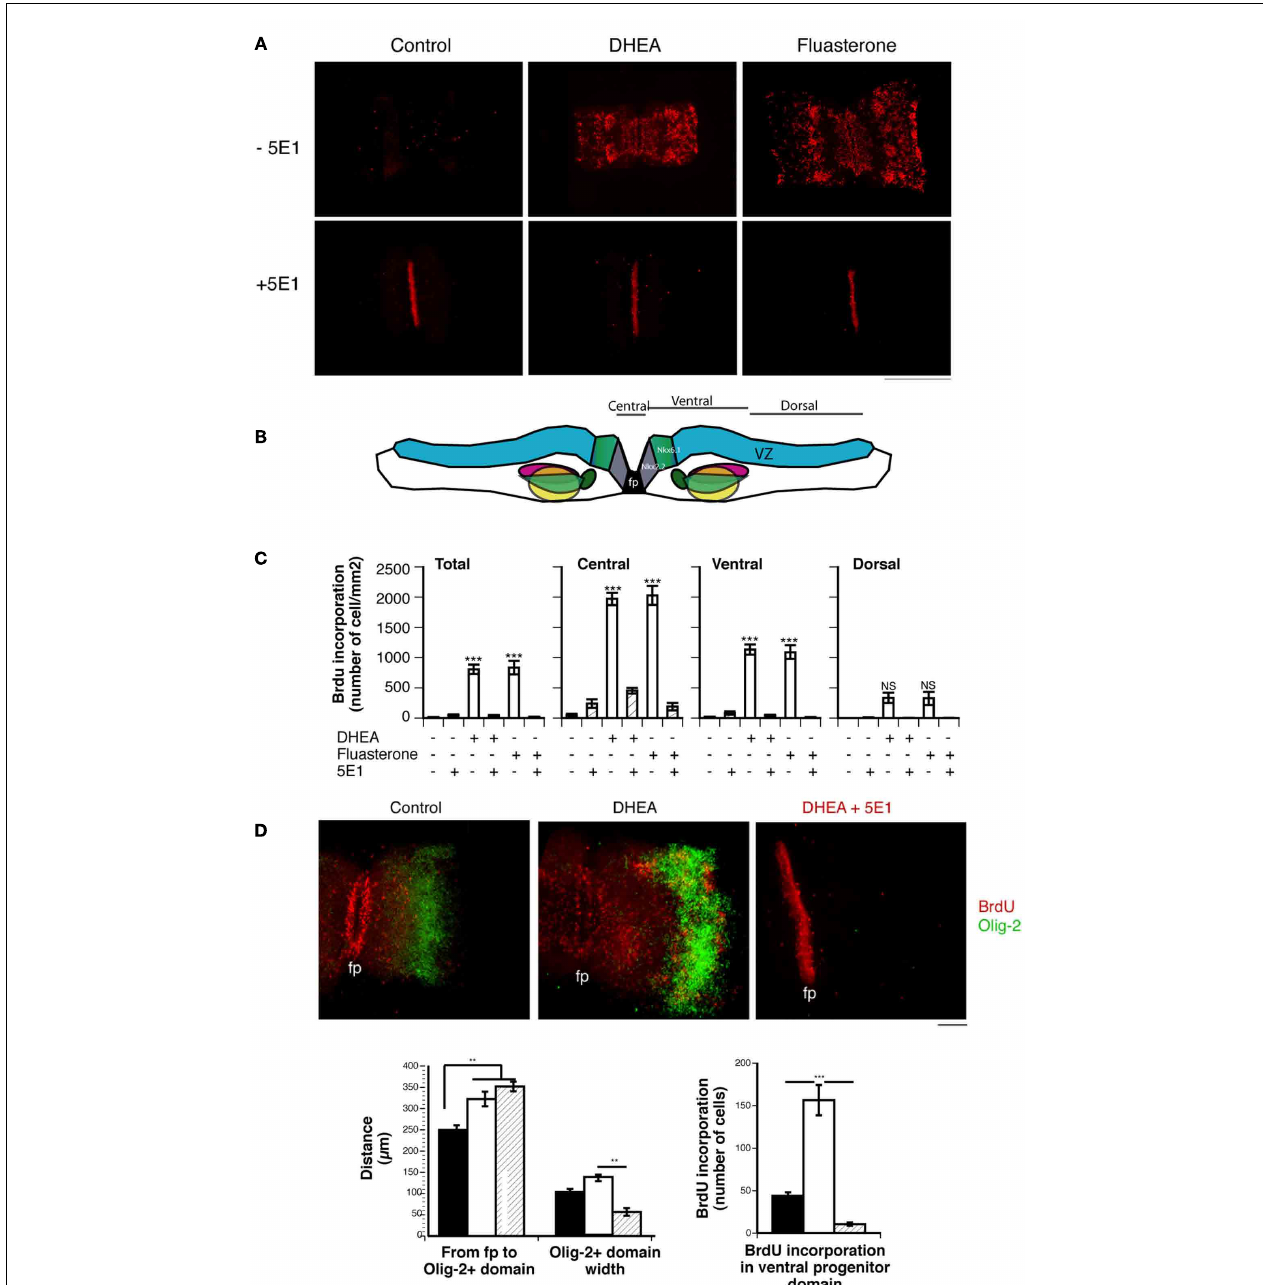
FIGURE 7 | Effect of DHEA on cell proliferation in spinal cord explants. (A) BrdU immunostaining of E11.5 lumbar spinal cord explants cultured in the absence (Control) or presence of DHEA or its derivative fluasterone, with or without the 5E1 anti-Shh antibody. Bar = 0.5mm. (B) Layout of the spinal cord explant in the collagen matrix.The different regions in which BrdU incorporation was quantified are shown. (C) Quantification of BrdU incorporation in the whole explant (Total), central part ( ∼ 100 μ m around the floor plate), and ventral and dorsal domains. Results are expressed as a number of immunopositive BrdUcells/mm 2 to correct for different sizes of explants. (D) Photomicrograph of whole spinal cord explants immunostained for BrdU (red) and Olig-2 (Green) showing the effect of DHEA on the